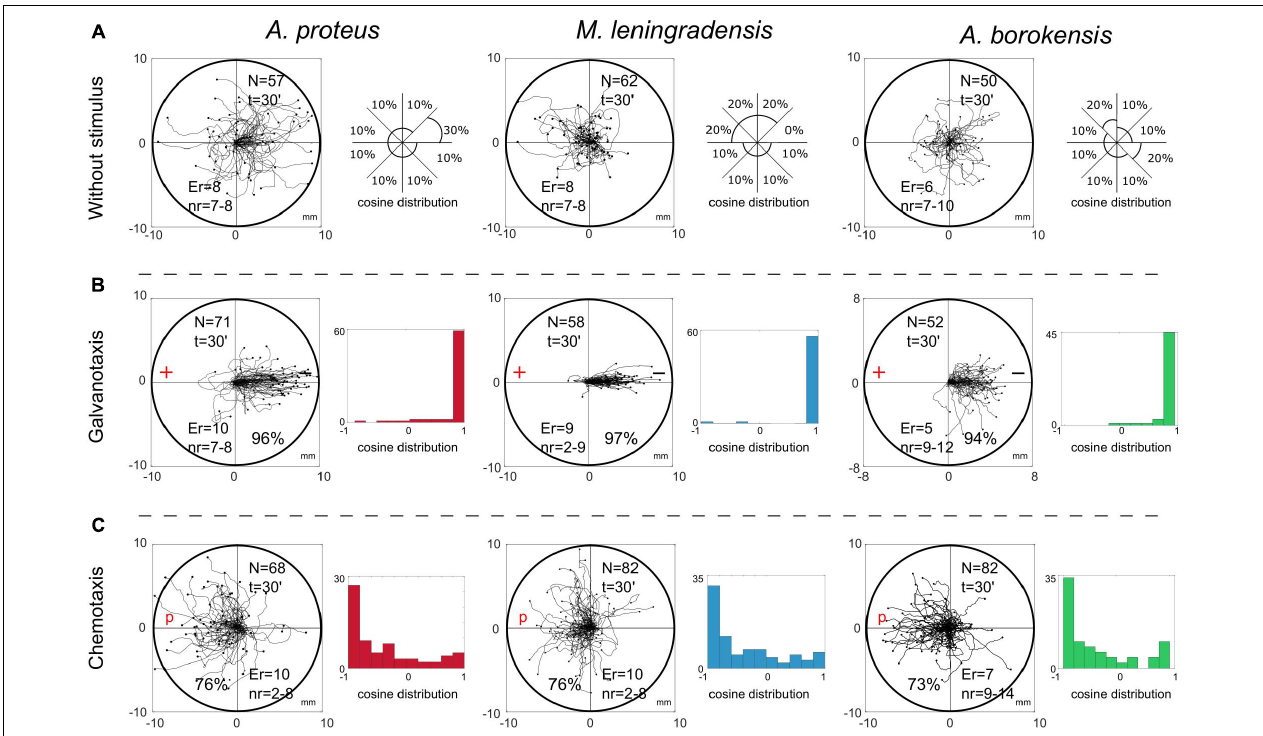
FIGURE 1 | Migration trajectories of the three species under external experimental conditions. Panels (A) show the migration without any stimuli by each of the three species ( A. proteus, M. leningradensis , and A. borokensis , respectively). Practically, the amoebae explored all the directions of the experimentation chamber. In addition to the trajectories, the approximated percentage of cells that displaced in certain portion of the exploration chamber is represented. The space has been divided in 8 sections (thus π / 4 angle amplitude was used for determining the regions). In panels (B) , the locomotion trajectories during galvanotaxis are depicted (96% of A. proteus , 97% of M. leningradensis , and 94% of A. borokensis migrated toward the cathode). Next to the trajectories, the respective histograms of the displacement cosines are illustrated. Finally, panels (C) represent the migration during chemotaxis. 76%, 76% and 73% of the respective cells migrated toward the chemotactic gradient. Alongside the trajectories, the histograms for the angles of each trajectory have been illustrated. “N” is the total number of cells, “Er” is the experimental replications, “nr” is the number of cells per replication, “t” time of galvanotaxis or chemotaxis, “p” chemotactic peptide (nFMLP), “+” anode, “ − ” cathode. Both the x and y -axis show the distance in mm, and the initial location of each cell has been placed at the center of the diagram.